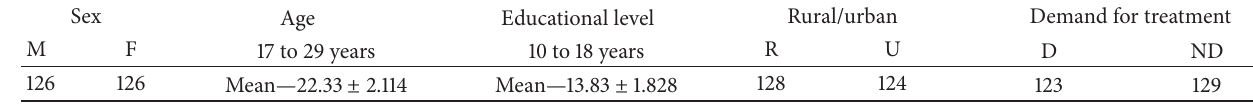
Table 1: Showing the descriptive statistics.